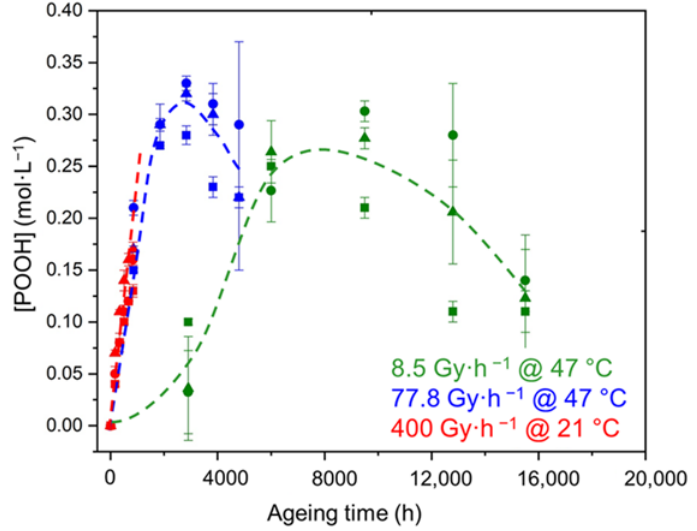
Figure 5. Changes in the POOH concentration of the Si ‐ XLPE matrix filled with 0 phr ( □ ), 25 phr ( ∆ ), and 50 phr ( ) of ATH, during its radio ‐ thermal exposure in air under 8.5 Gy ∙ h − 1 at 47 °C (green), under 77.8 Gy ∙ h − 1 at 47 °C (blue), and under 400 Gy ∙ h − 1 at 21 °C (red). Dashed lines are guides for the eye.